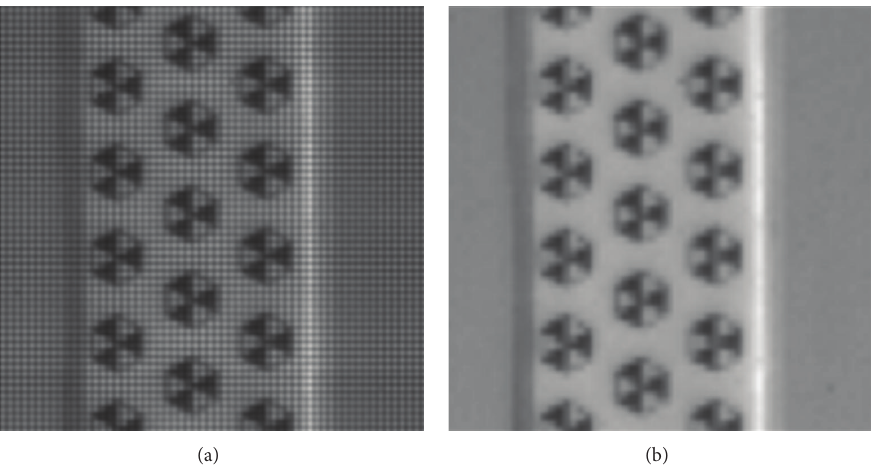
Figure 9: Bayer decoding. (a) Original captured image frame with many grid lines and (b) Bayer-decoded image.